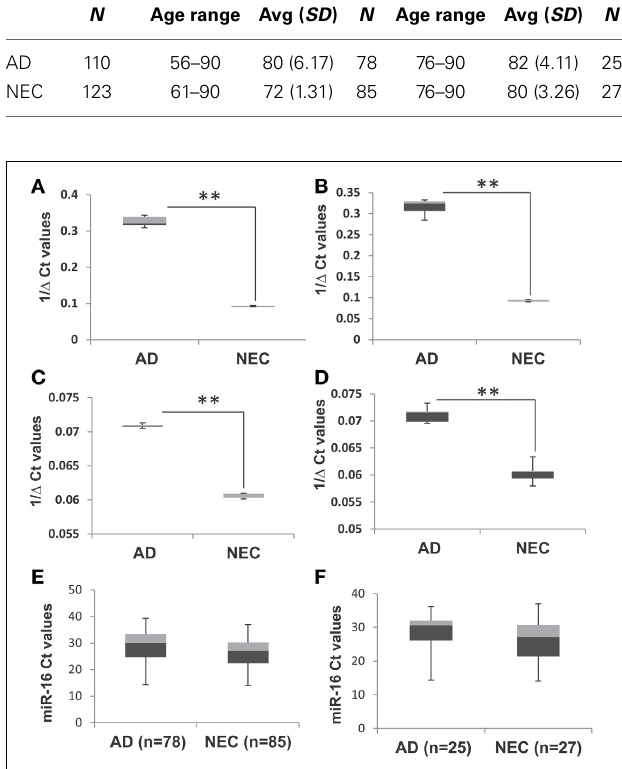
FIGURE 1 | Box plot representation of data from spike-in experiment with AD and NEC samples, miR-34c, with spike-in (A) and without spike-in (B) of Cel-39 ; and miR-34a with spike-in (C) and without spike-in (D). These figures show that levels of miR-34a and miR-34c are similar with and without spike-in experiments in both Alzheimer disease (AD) and normal elderly control (NEC) plasma samples. The Ct values of miR-16 in AD and NEC samples are represented as box plots in the whole population (E) and age-matched cohorts (F) . These figures indicate that levels of miR-34a and miR-34c are of the same range in both total and age-matched cohorts among both AD and NEC plasma samples. Student’s t- test was used to determine statistical significance; ∗∗ P < 0 .